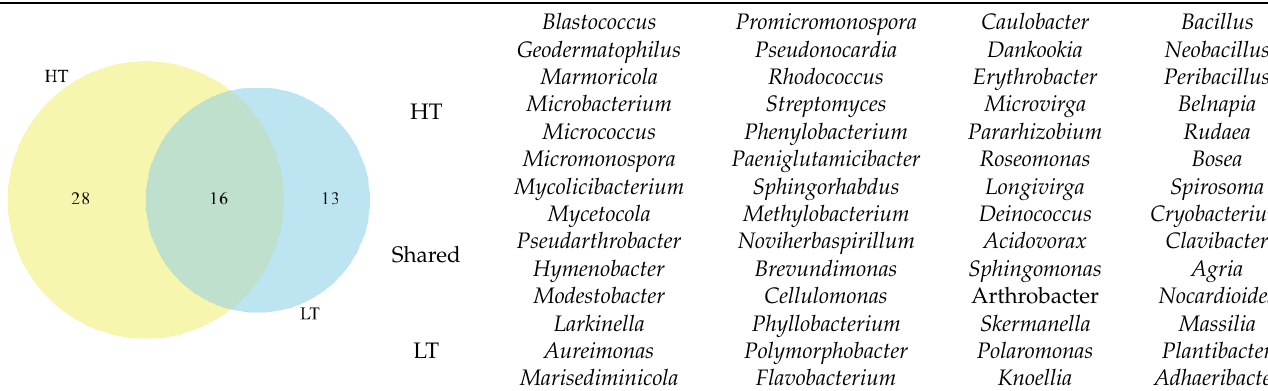
Table 1. Taxonomic diversity at different culture temperatures used. Venn diagram comparing the genera isolated at HT and LT (Left figure).